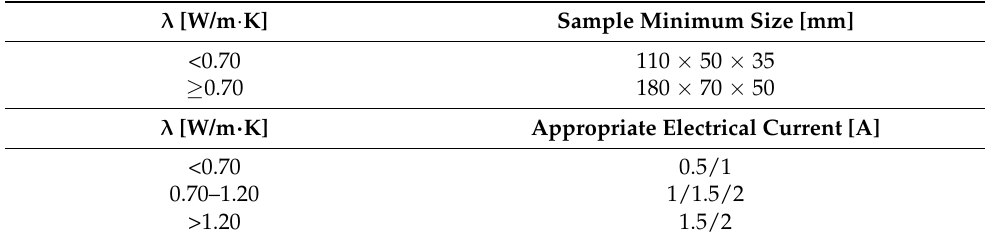
Table 5. Sample minimum size and appropriate electrical current of the